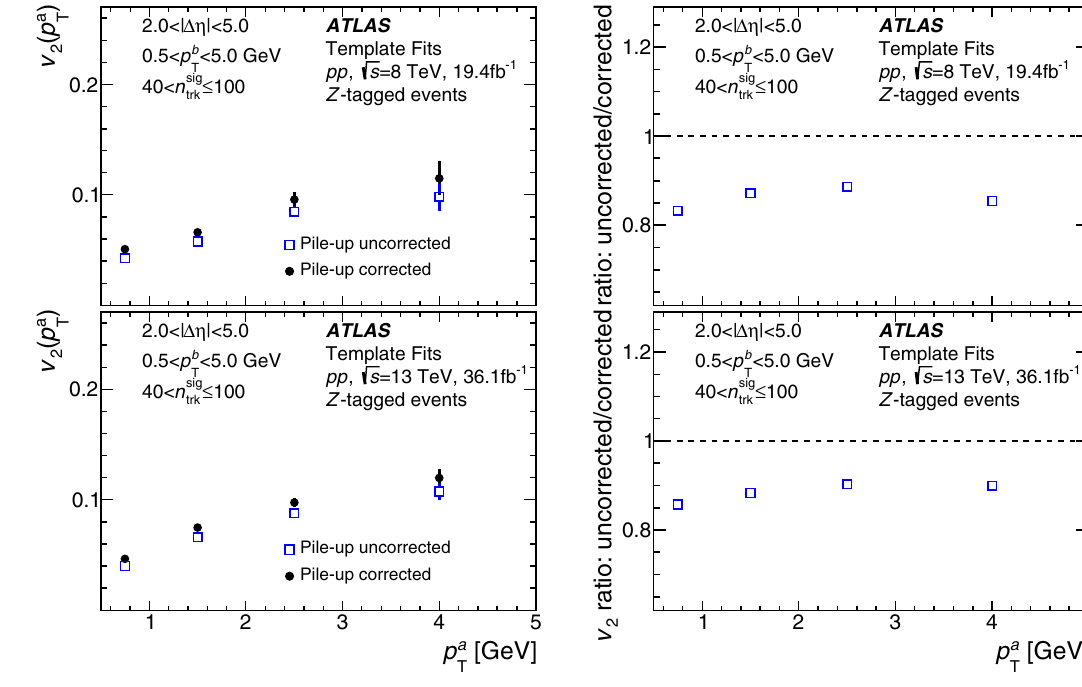
Fig. 10 Top left panel compares the v 2 values as a function of p T in the 8 TeV data, when correcting (solid-black points) and not correcting (open blue points) for pile-up pairs. The plots are for the 40–100 n sig interval. The blue points correspond to the Fourier coefficients of the